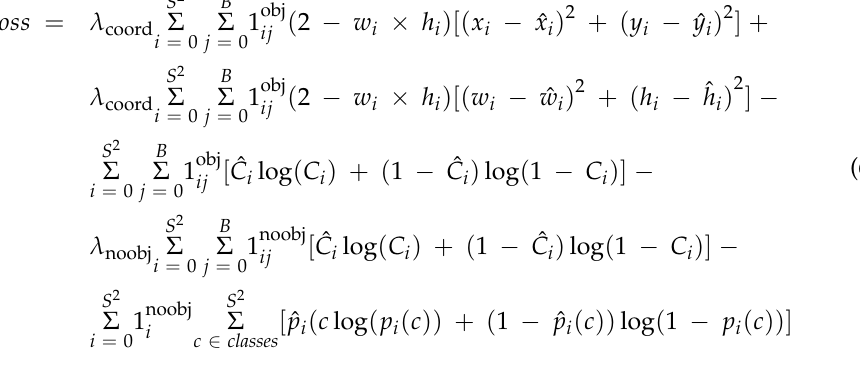
Table 1. The meaning of each parameter of the loss function.